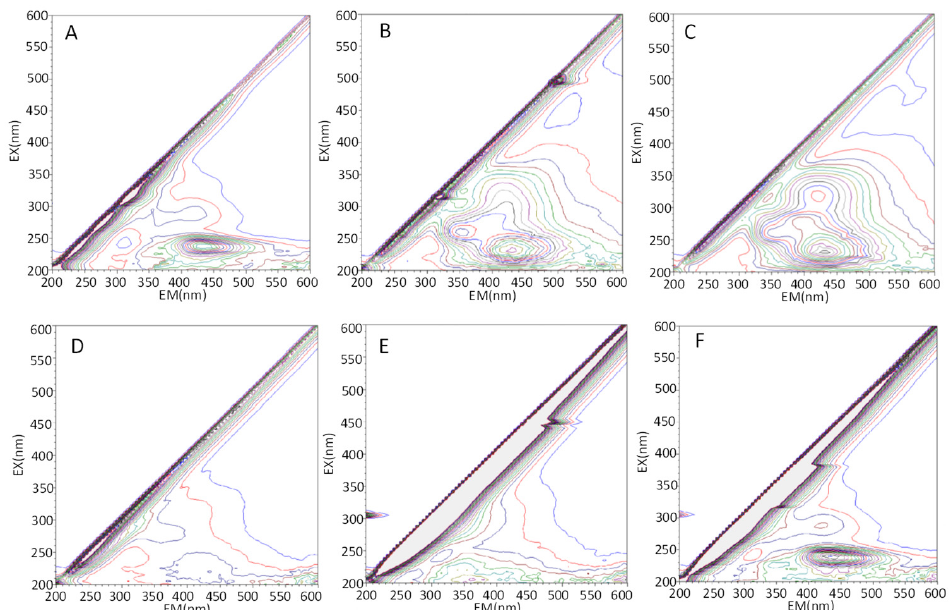
Figure 7. 3D EEM spectra for synthetic batik wastewater containing 48 mg/L RB5 and 48 mg/L RO16 treated by ozonation for 0 min ( A ), 1 min ( B ), 3 min ( C ), and 15 min ( D ); ozonation for 15 min followed by biodegradation for 14 days ( E ); and biodegradation for 14 days ( F ). All samples were 5-fold diluted for analysis.